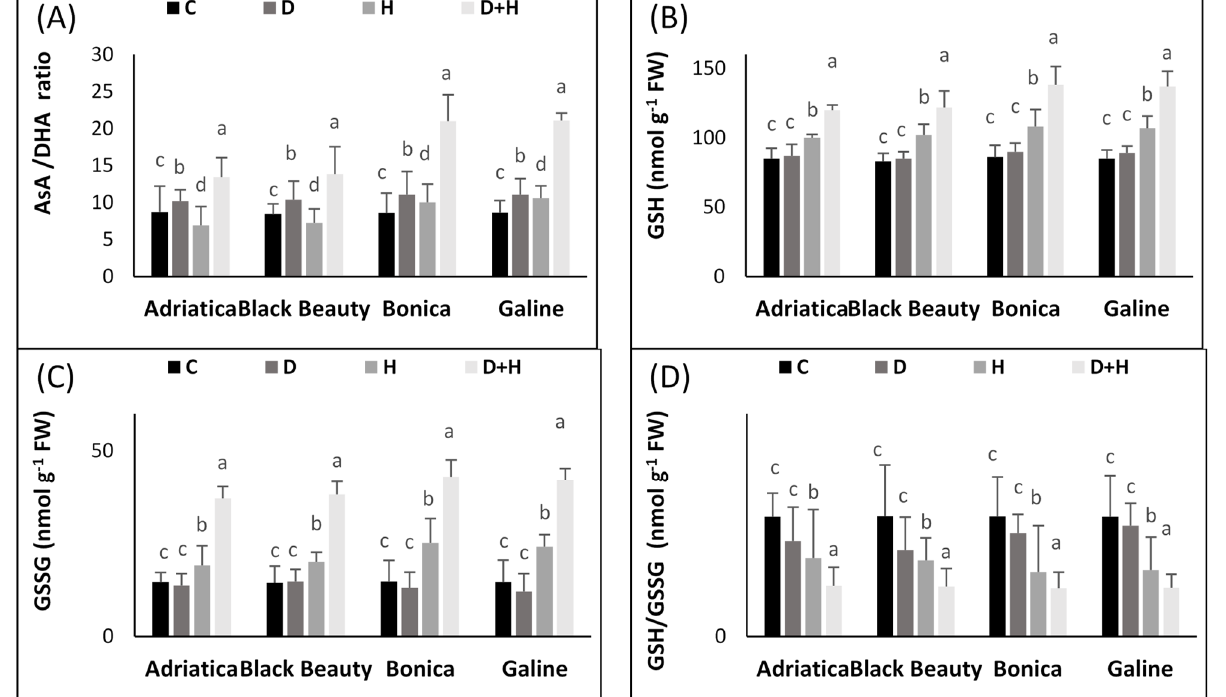
Figure 6. Changes in ( A ) ascorbic acid/ dehydroascorbate (AsA/DHA), ( B ) (GSH), ( C ) (GSSG), and ( D ) (GSH/GSSG) of four eggplant cultivars under individual and combined stresses. Data are the means ± SE ( n = 5). Significant dissimilarities are shown by different lower-case letters between treatments ( p ≤ 0.05) based on Tukey’s test. (C, control; H, heat stress; D, drought stress; H + D, heat + drought stresses).